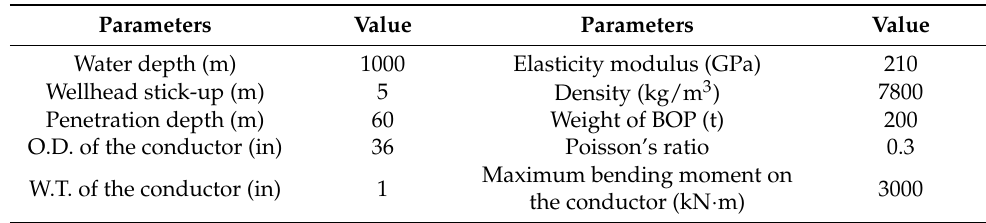
Table 1. Conductor parameters.